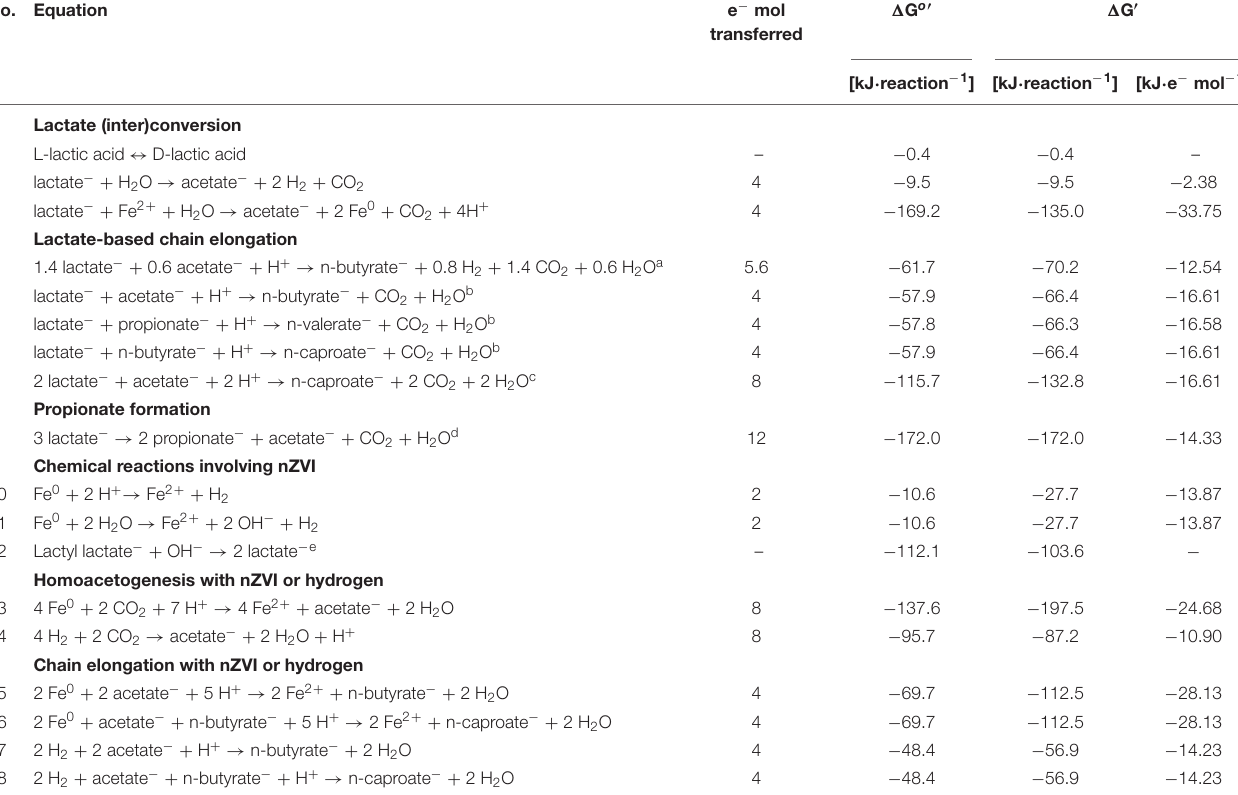
TABLE 1 | Thermodynamics of (bio)process reactions potentially involved in lactate-based chain elongation microbiomes and nZVI conversion. No. Equation e − mol